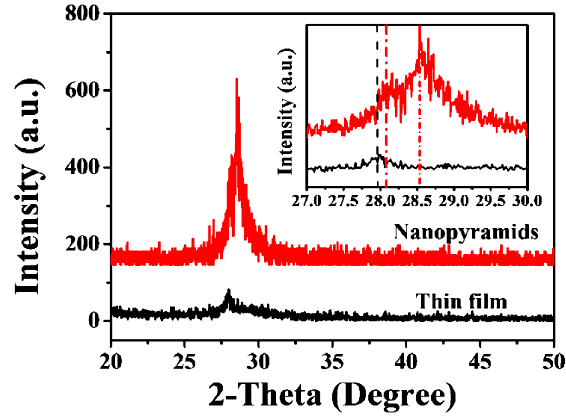
Figure 1. Room temperature X-ray diffraction (XRD) pattern for the VO 2 nanofilms deposited on the silicon substrate before and after oxygen injection. The inset shows the enlarged results of the XRD data obtained between 27° and 30° for these films.